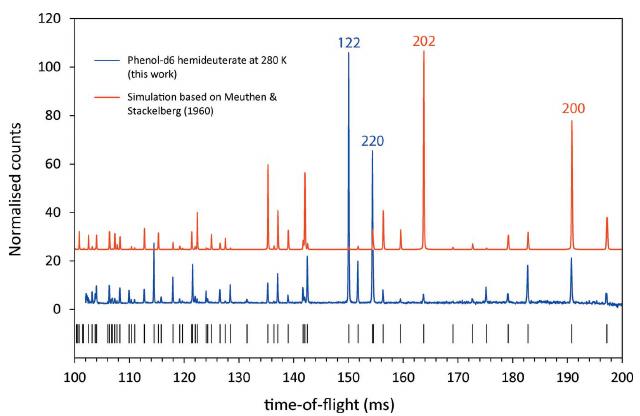
Figure 1 Time-of-flight (TOF) data collected in HRPD’s backscattering detectors over the range 100–200 ms at 280 K (blue) compared with a simulated diffraction pattern (red) based on the structure model of Meuthen & von Stackelberg (1960). The latter structure was ‘completed’ with geom- etrically positioned deuterons 1.080 A ˚ from, and co-planar with, the phenyl carbons, a deuteron placed 0.990 A˚ from the hydroxyl oxygen along the O–O vector that gave the smallest C—C—O—D torsion angle; the symmetry-unique water deuteron was placed 0.990 A˚ from the water oxygen along the remaining O–O vector. In the experimentally observed diffraction pattern, the strongest Bragg peaks in this TOF range are 122 and 220. In contrast, the intensity of 122 from the simulated pattern is extremely weak and 202 has the greatest intensity